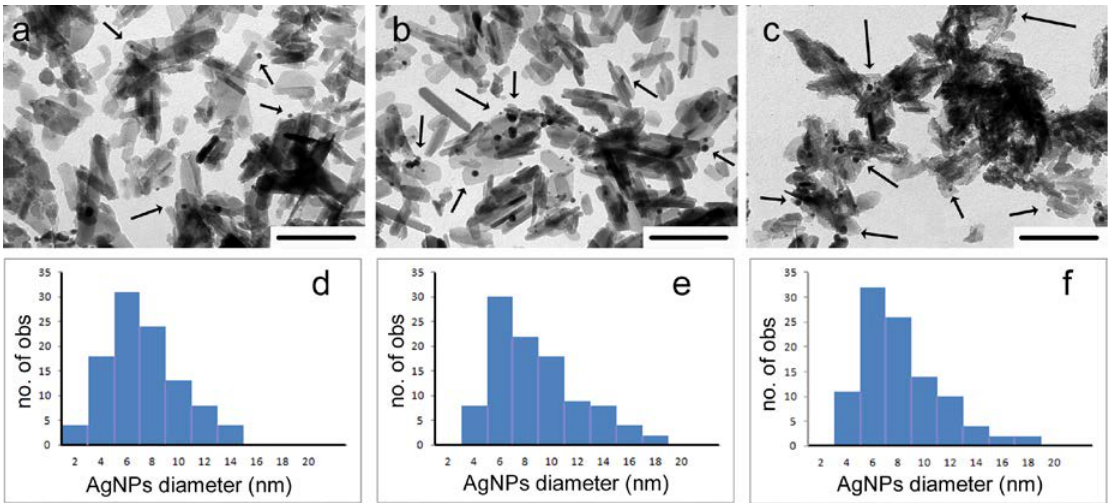
Figure 2. Transmission electron microscopy images of materials functionalized with AgNPs and related AgNPs size distribution diagrams: ( a , d ) HA-Ag50; ( b , e ) HSA10-Ag50 and ( c , f ) HSA20-Ag50. The arrows in micrographs indicate AgNPs. Bars = 200 nm.